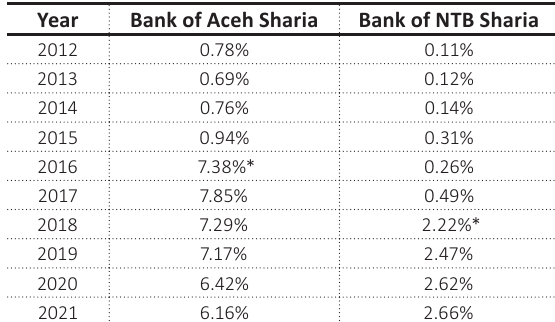
Table 2. Market share of converted